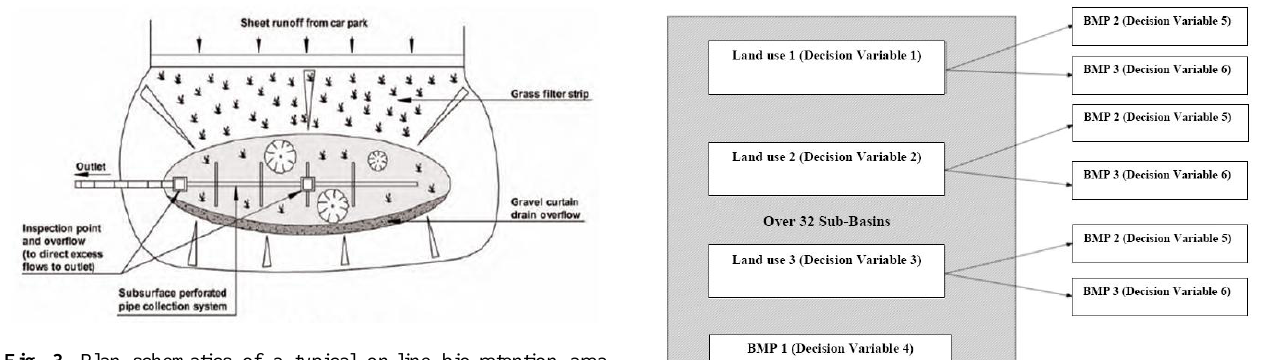
Fig. 3. Plan schematics of a typical on-line bio-retention area (Woods-Ballard et al., 2007).